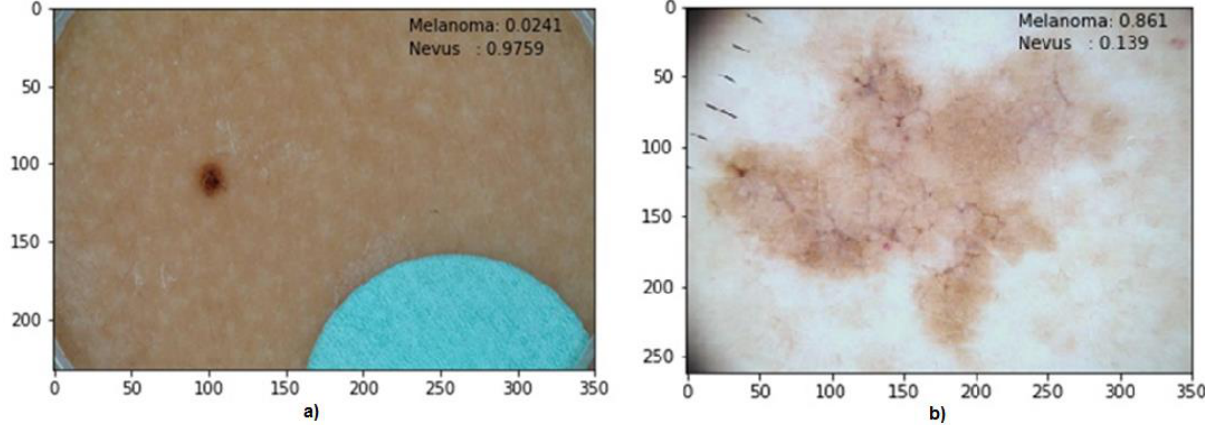
Figure 4. The examples of classification of a) nevus, b)